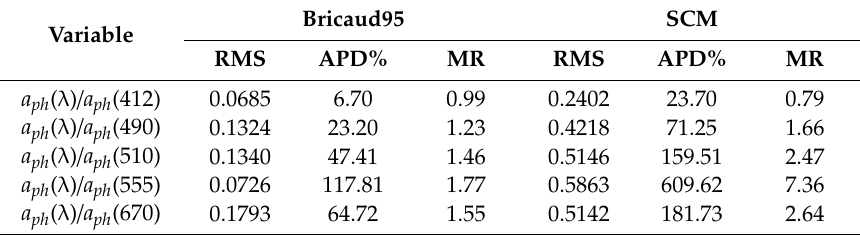
Table 5. Statistics of the Bricaud95-method and the SCM-method derived a ph ( λ ) / a ph